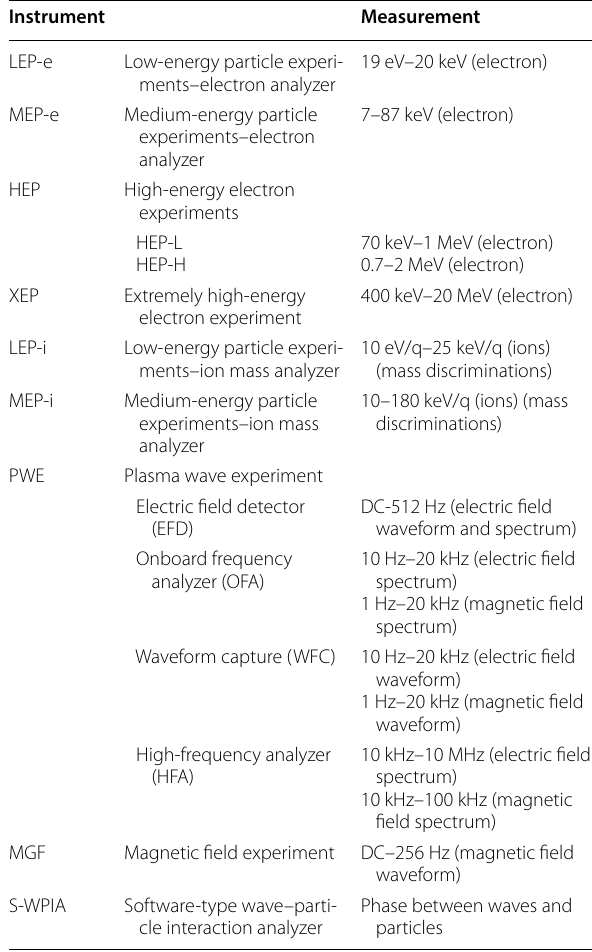
Table 2 List of science instruments onboard ERG